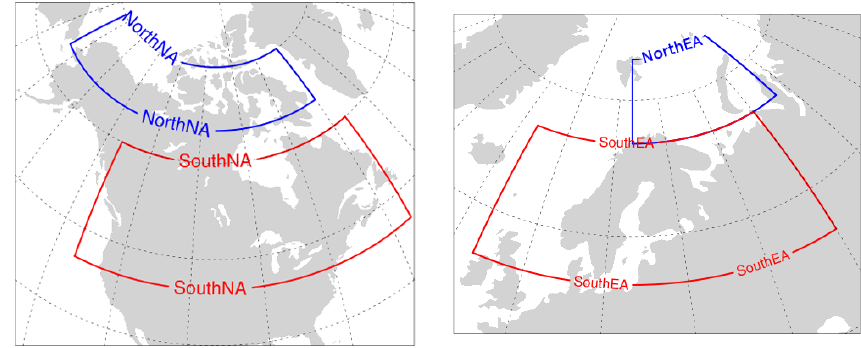
Figure 8. Selected north and south zones over North America and Eurasia for PD sensitivity analysis.